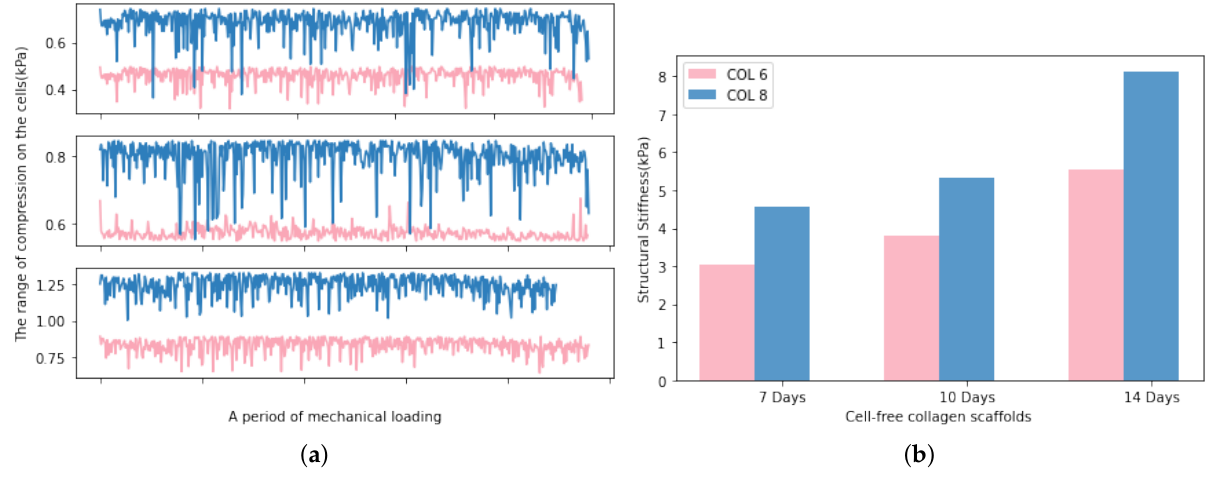
Figure 11. ( a ). The average compression values determined in the cells, the upper subgraph displays the first 7 days, the middle one displays 10 days and the bottom one displays the 14 days. ( b ). The average structural stiffness of COL-6 and COL-8 implants during 7 days, 10 days, and 14 days,